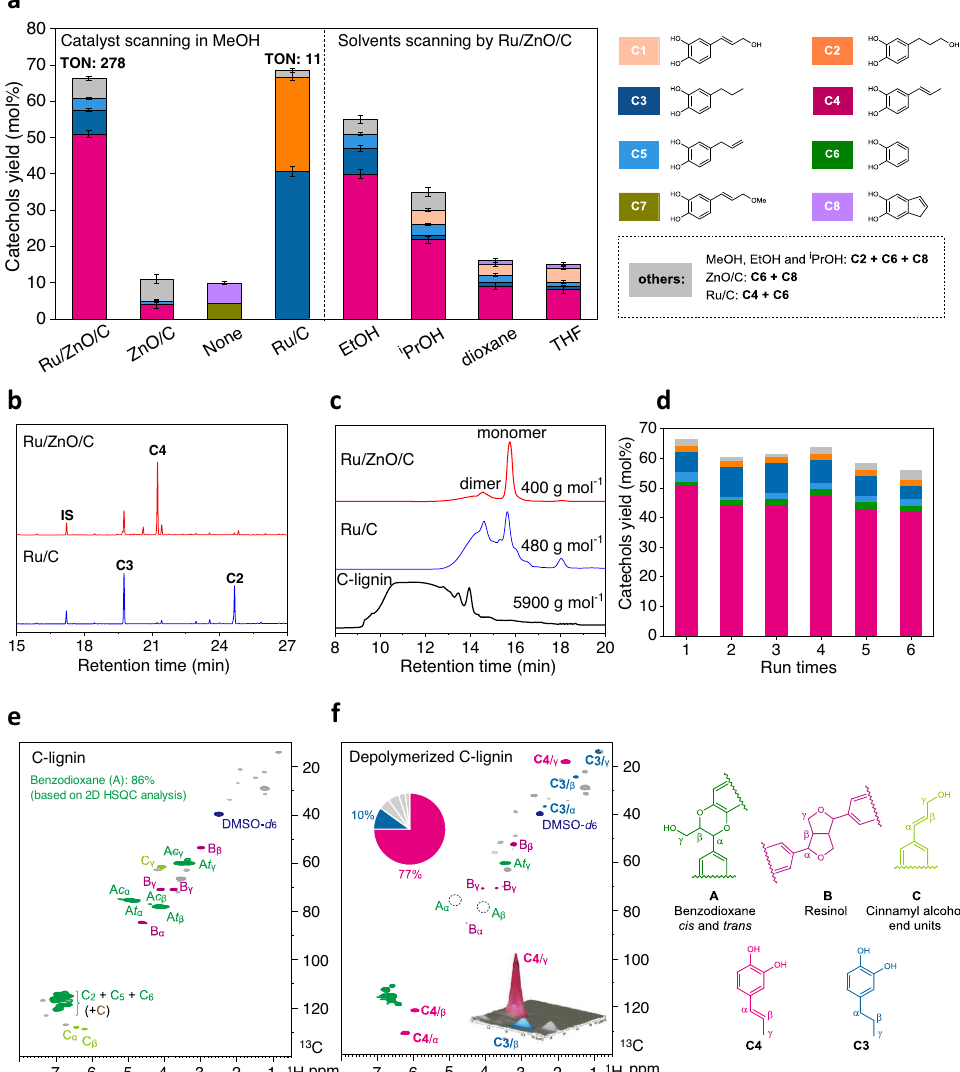
Fig. 3 Hydrogenolysis of C-lignin over Ru/ZnO/C catalyst. a Comparison of catechols yield and selectivity of different catalysts and solvents, and corresponding products distributions. Reaction conditions: C-lignin (50 mg), catalyst (15 mg, 30 wt%), solvent (10 mL), 200 °C, 3 MPa H 2 , and 4 h. TON means turnover numbers. (Error bars = standard deviation; n = 2; for Ru/ZnO/C, n = 3). b Comparison of the catechols products (trimethylsilyl derivatives) after the Ru/ZnO/C and Ru/C catalyzed processing of C-lignin by GC spectra. c Molecular weight distribution of C-lignin and oily products from catalytic reactions via GPC. d The reusability of Ru/ZnO/C catalyst. e 2D NMR spectrum of C-lignin isolated from castor seed coats (DMSO- d 6 ). f 2D NMR spectrum of oily product from Ru/ZnO/C-catalyzed reaction (DMSO- d 6 ), and corresponding structural distributions of C-lignin and main